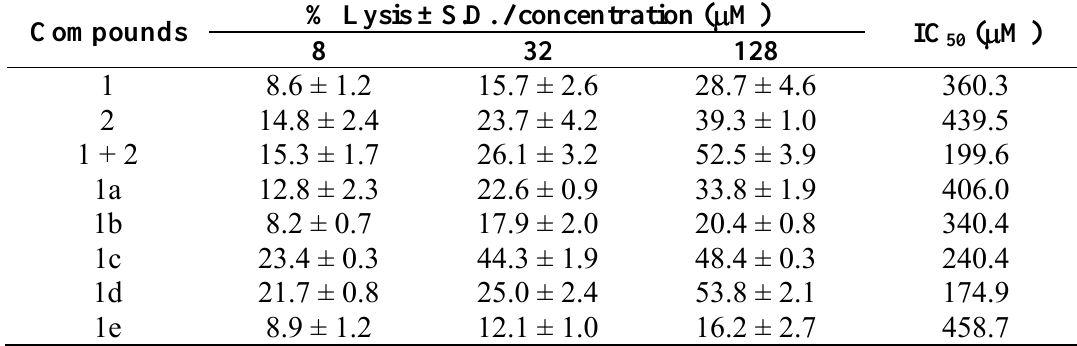
Table 1. In vitro leishmanicidal activity of the pure compounds isolated from M. langsdorffii and of ursolic acid